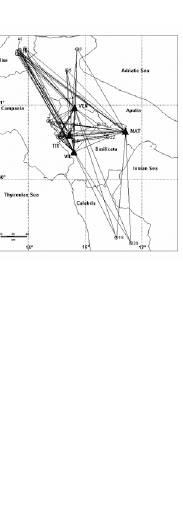
Fig. 1. The major stages of the analysis. GHCN = = Global Historical Climatology Network; CRU = Cli- mate Research Unit, University of East